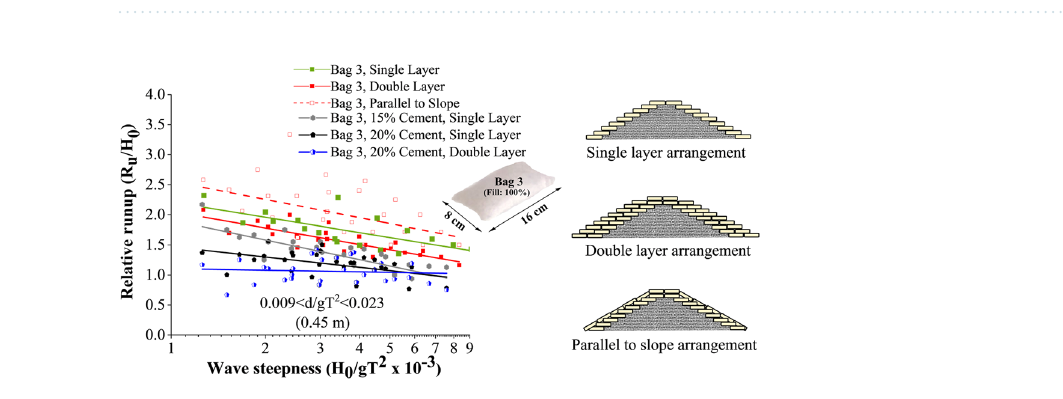
Figure 18. Relative wave runup for various placement modes of Bag